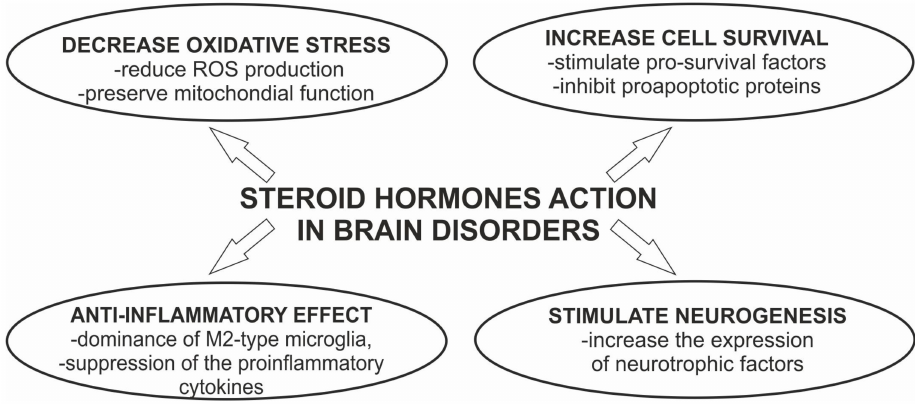
Figure 2. Neuroprotective effects of steroid hormones in brain